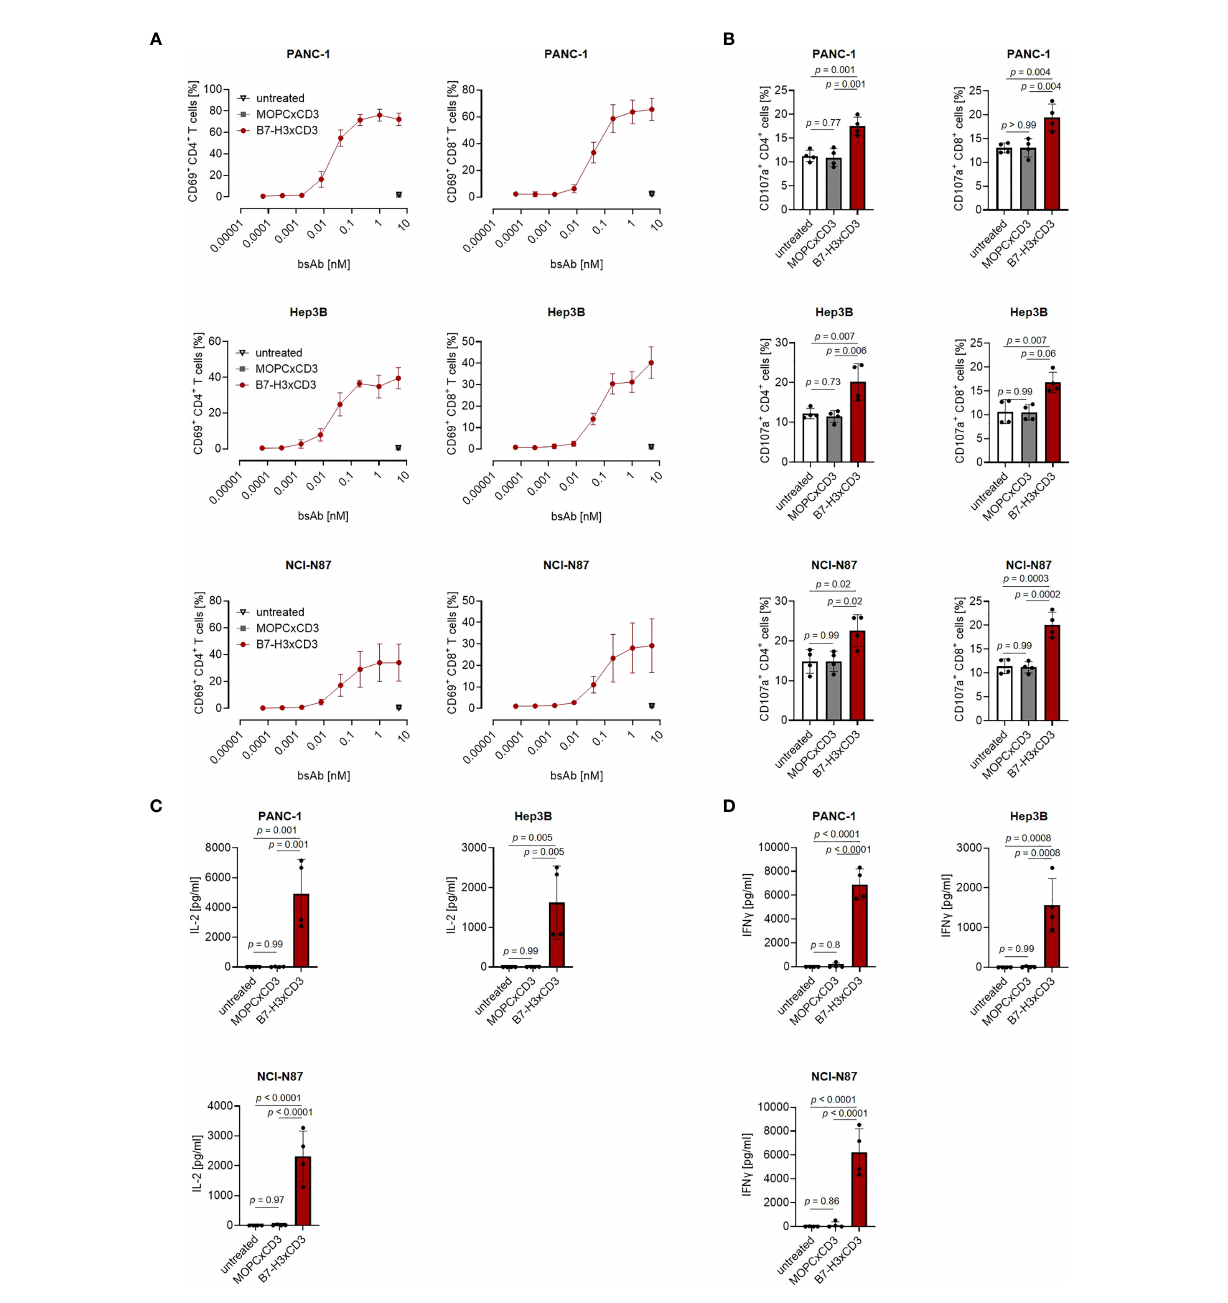
FIGURE 2 Induction of T cell activation against gastrointestinal cancer cell lines by CC-3. Monocyte-depleted PBMC of healthy donors were incubated with the indicated tumor cell lines (E:T 4:1) in the presence or absence of CC-3 or MOPCxCD3. If not stated otherwise, all constructs were used at 1 nM. (A) Activation of CD4+ and CD8+ T cells was determined by fl ow cytometric analysis for CD69 expression after 24 hours. Combined data obtained with PBMC of three independent donors are shown. (B) Degranulation of CD4+ and CD8+ T cells was determined by expression of CD107a after 4 h. Combined data obtained with PBMC of four independent donors are shown. (C) IL-2 and (D) IFN g levels in culture supernatants were measured after 24 h using LEGENDplex assays. Combined data obtained with PBMC of four independent donors are shown. E:T, effector to target; PBMC, peripheral blood mononuclear